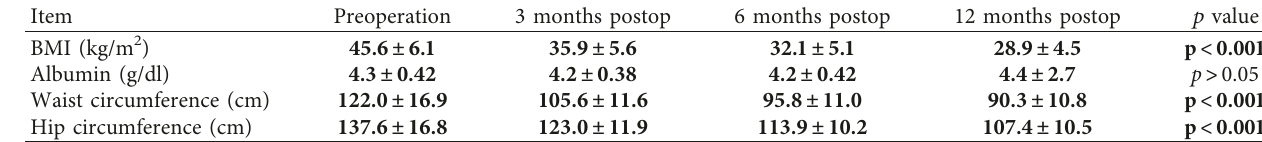
Table 1: Changes of BMI, blood albumin, waist circumference, hip circumference, and bioelectrical impedance analysis ( x ± s ).